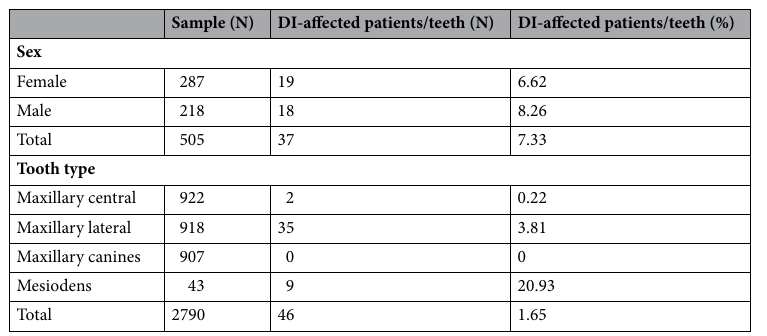
Table 1. Frequencies and percentages of DI-affected patients/teeth according to sex and tooth